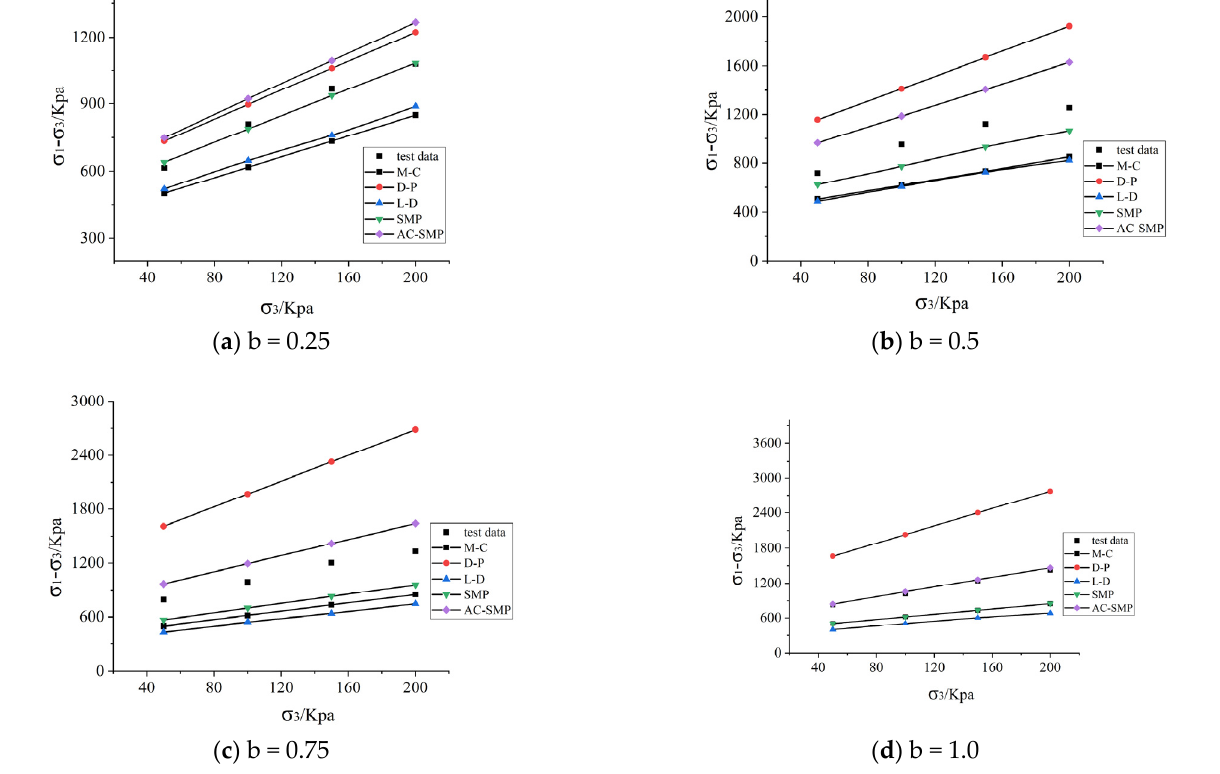
Figure 4. Comparison between true triaxial test data and strength criterion under different b values. ( a ) Comparison of true triaxial test data and strength criterion at b=0.25. ( b ) Comparison of true triaxial test data and strength criterion at b=0.5. ( c ) Comparison of true triaxial test data and strength criterion at b=0.75. ( d ) Comparison of true triaxial test data and strength criterion at b=1.